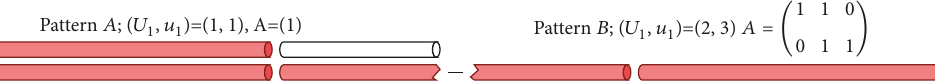
Figure 2: Patterns for producing 4-meter pipes from single-size, 6-meter stocks through cutting and cutting and welding.